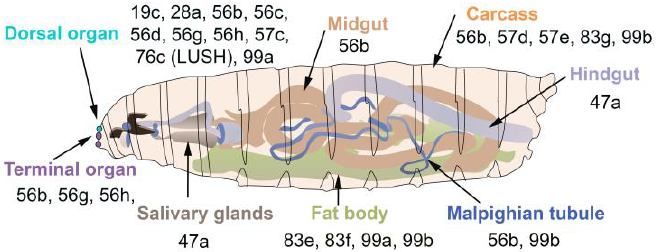
Figure 3. OBPs expressed in the olfactory gustatory and digestive organs of D. melanogaster larvae. The larval dorsal organ (turquoise) detects volatile odorants, while the larval terminal organ (purple) detects both soluble and volatile chemicals.